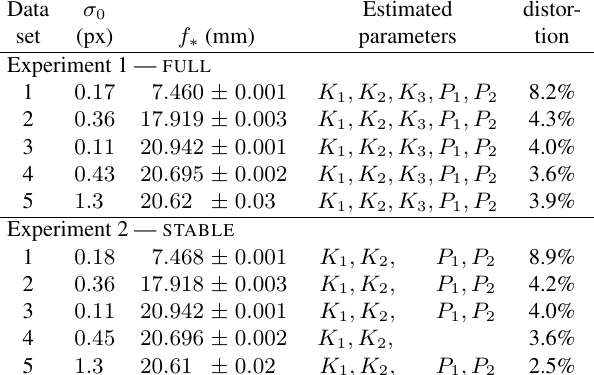
Figure 3: Initial EO and OP values for f 0 = 0 . 3 f ∗ (left) and f 0 = 3 f ∗ (right) for data set 3 ( f ∗ = 20 . 942 mm). Initial (white) and optimal (blue) camera positions are connected by dotted lines. Initial OP coordinates are red, optimal blue. Given the smaller f 0 value, the distance to the target is underestimated and the cameras cluster above the centre of the target. Their incorrect position affects the initial OP values as well. Given the larger f 0 value, the distance to the target is overestimated and the cameras fan out radially away from the target. In both cases, the orientations of the cameras are approximately correct. Table 3: The calibration results of the FULL experiment (upper half) and STABLE experiment (lower half). The maximum distor- tion is computed at the sensor corners and is given in percent of the sensor half-diagonal. Max Data σ 0 Estimated